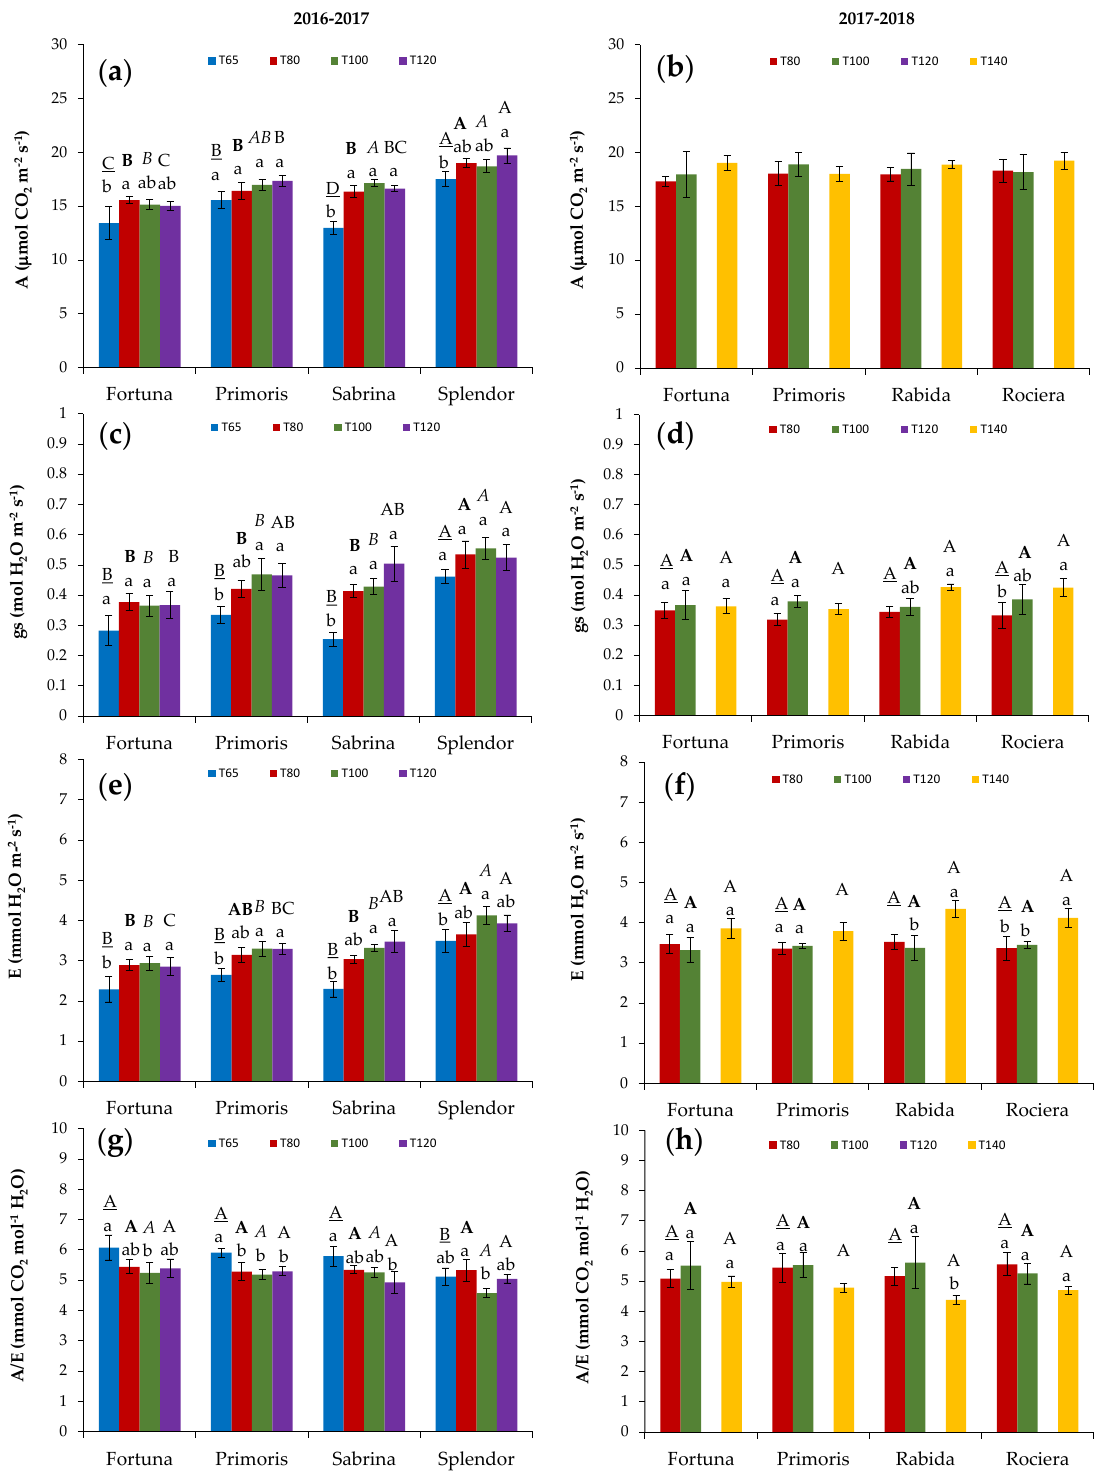
Figure 5. Mean values ( ± SE; n = 6) of ( a , b ) net assimilation rate ( A ); ( c , d ) stomatal conductance (gs); (e , f ) transpiration rate ( E ) and ( g – h ) instantaneous water use efficiency ( A / E ) on the study cultivars under the water treatments in 2016–2017 and 2017–2018. Different lower-case or upper-case letters indicate significant ( p < 0.05) differences between water treatments or among cultivars re- spectively.